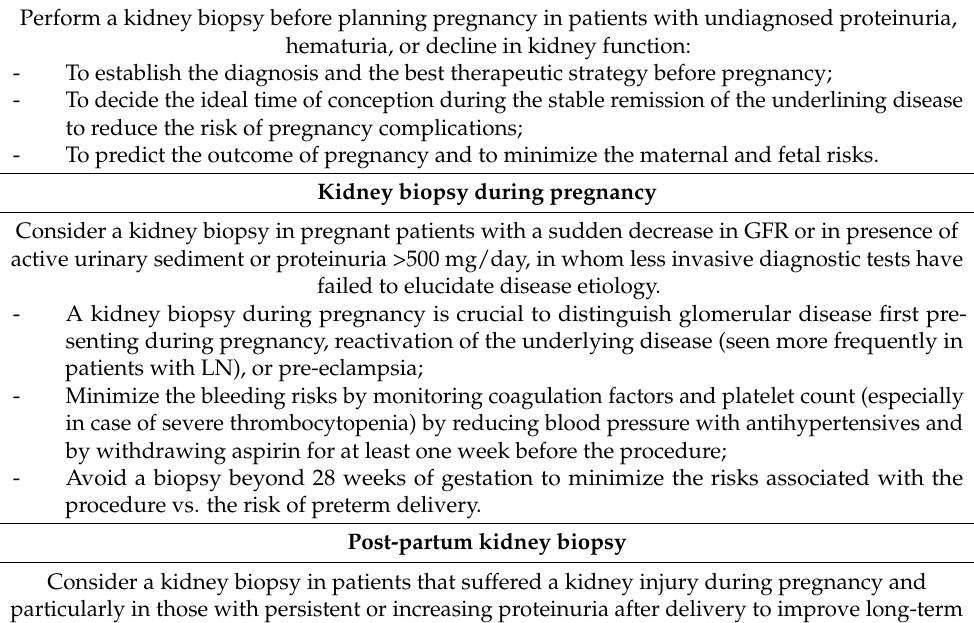
Table 1. Recommendations for kidney biopsy in pregnant women with glomerular disease. GFR, glomerular filtration rate; LN, lupus nephritis. Kidney biopsy before